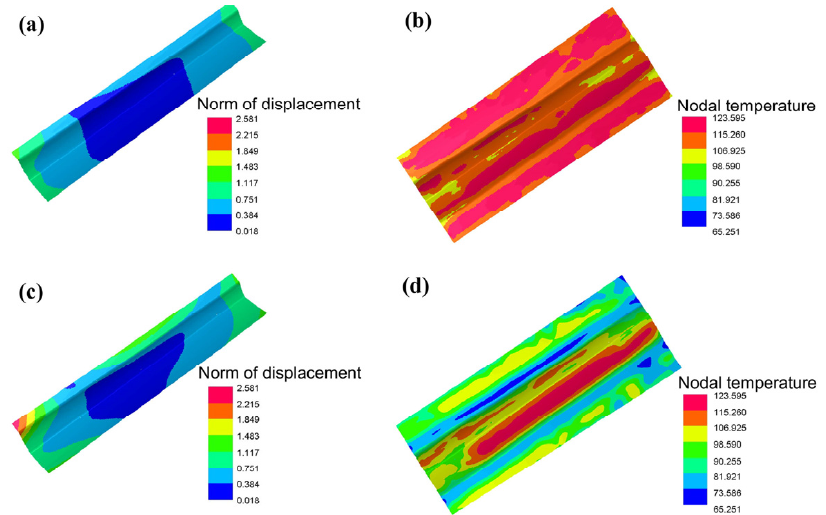
Figure 8. The springback and temperature distribution of the skin formed by the two processes: ( a , b ) Hot stamping. ( c , d ) Drawing. ( a , b ) Hot stamping. ( c , d )